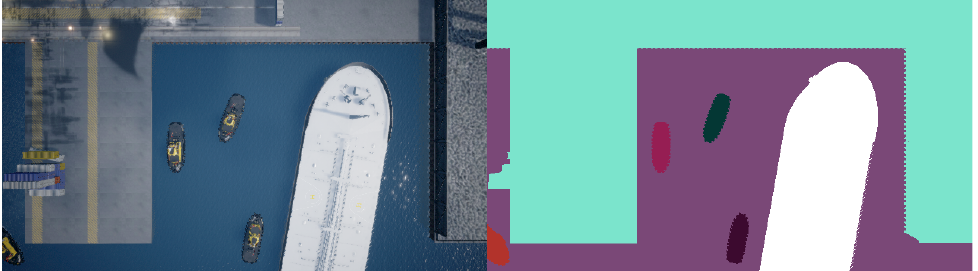
Figure 10. ( Left ) Raw image. ( Right ) Annotated ground-truth